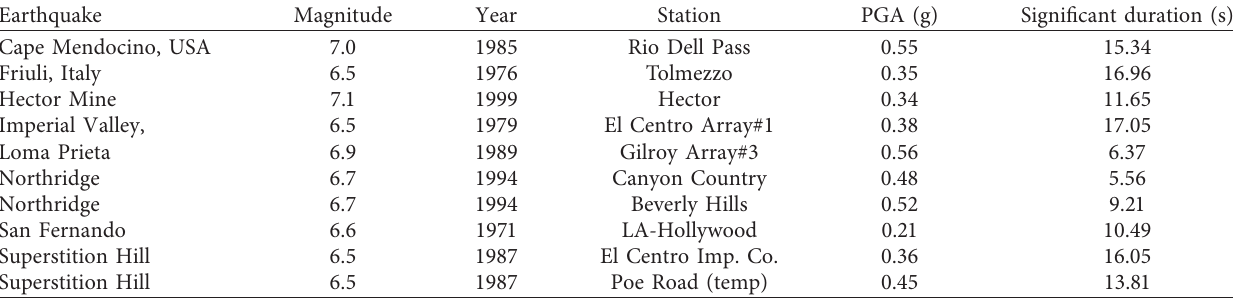
Table 4: Short-duration set